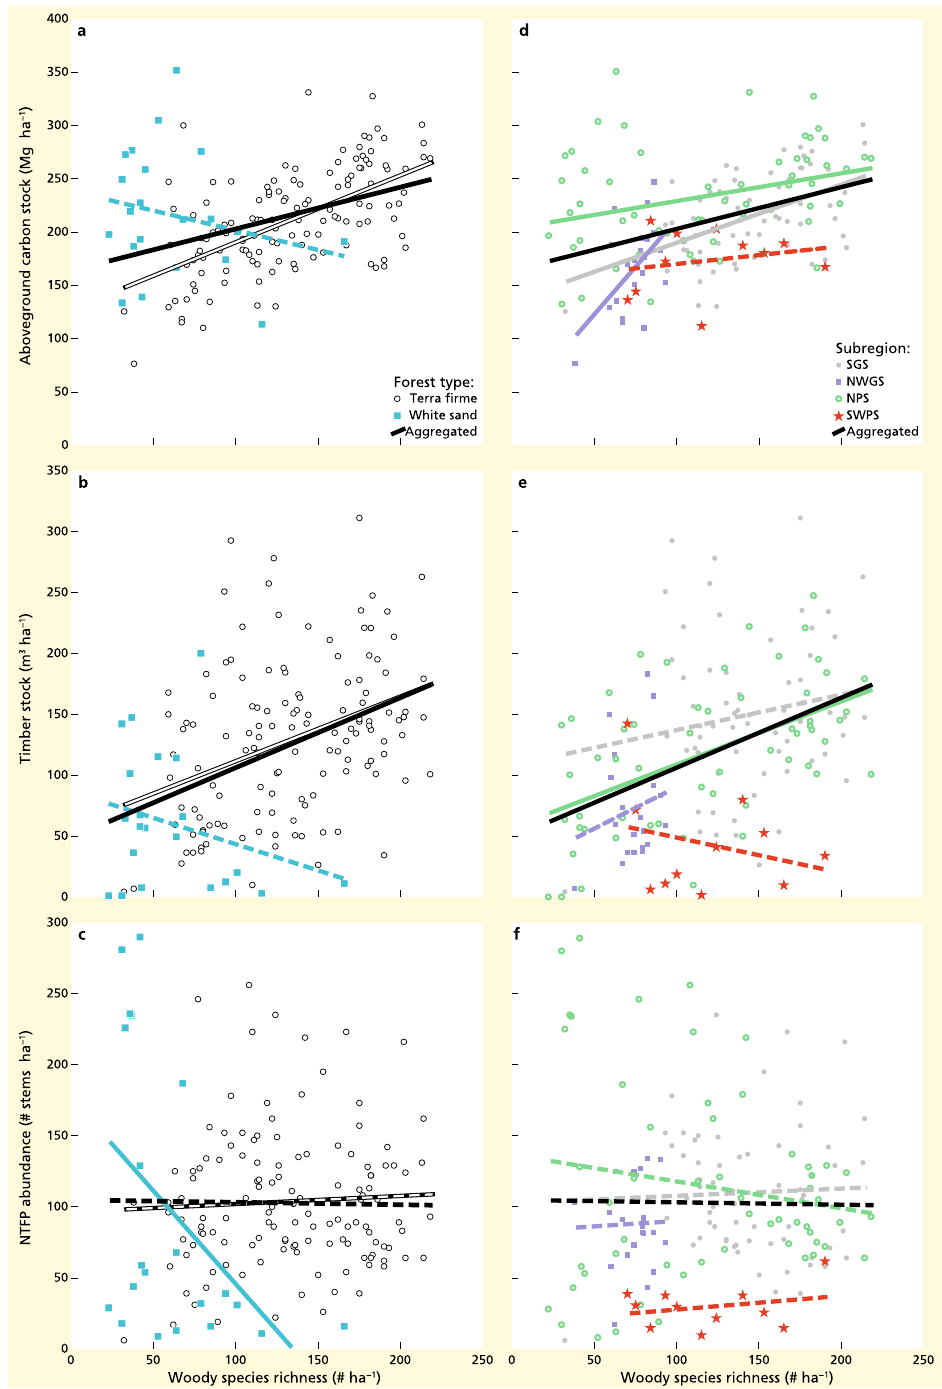
Figure 1. Visualisation of linear bivariate relationships between species richness and carbon stock, timber stock, and non-timber forest products (‘NTFP’) abundance, across and within two forest types and four biogeographical subregions of the Guiana Shield. Showing relationships between species richness and carbon stock (panels a and d ), between species richness and timber stock (panels b and e ), and between species richness and NTFP abundance (panels c and f ). Relationships across all forest types and subregions indicated by black lines (n = 151), within terra firme forests by white lines (n = 130), within white sand forests by blue lines (n = 21), within the Southern Guiana Shield by gray lines (n = 63; SGS), within the north-western Guiana Shield by purple lines (n = 21; NWGS), within the northern Pleistocene sands by green lines (n = 56; NPS), and within the south-western Pleistocene sands in the upper Rio Negro region by red lines (n = 11; SWPS). Solid lines indicate significant relationships ( p < 0.05) and dashed lines non-significant relationships ( p ≥ 0.05). Forest plots are coloured according to forest type or subregion. Model details are included in Tables S2.4 and